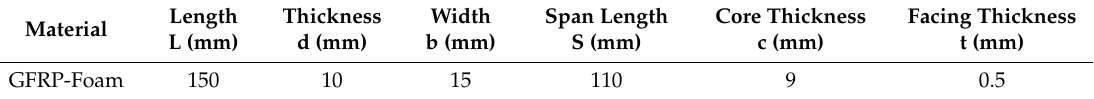
Table 1. Dimensions of sandwich specimens tested in three-point static and fatigue bending.